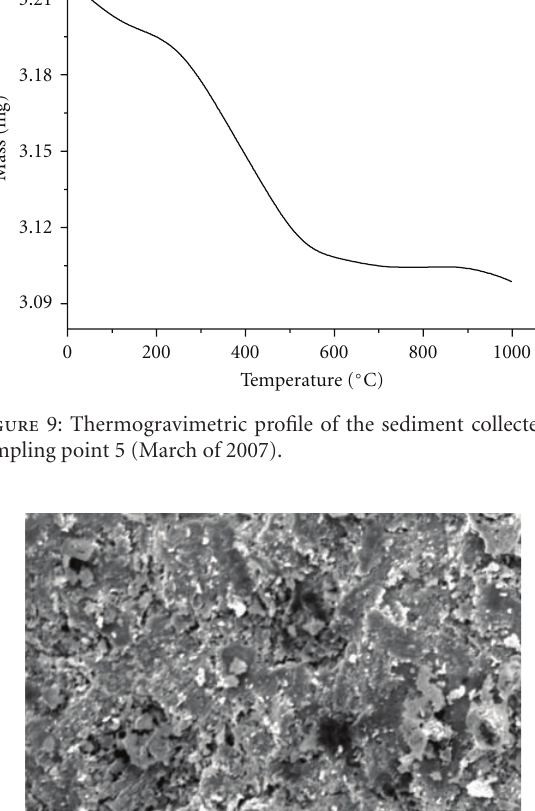
Table 7: Clay and total organic matter levels (%, m/m) of sediments collected in March of 2007.